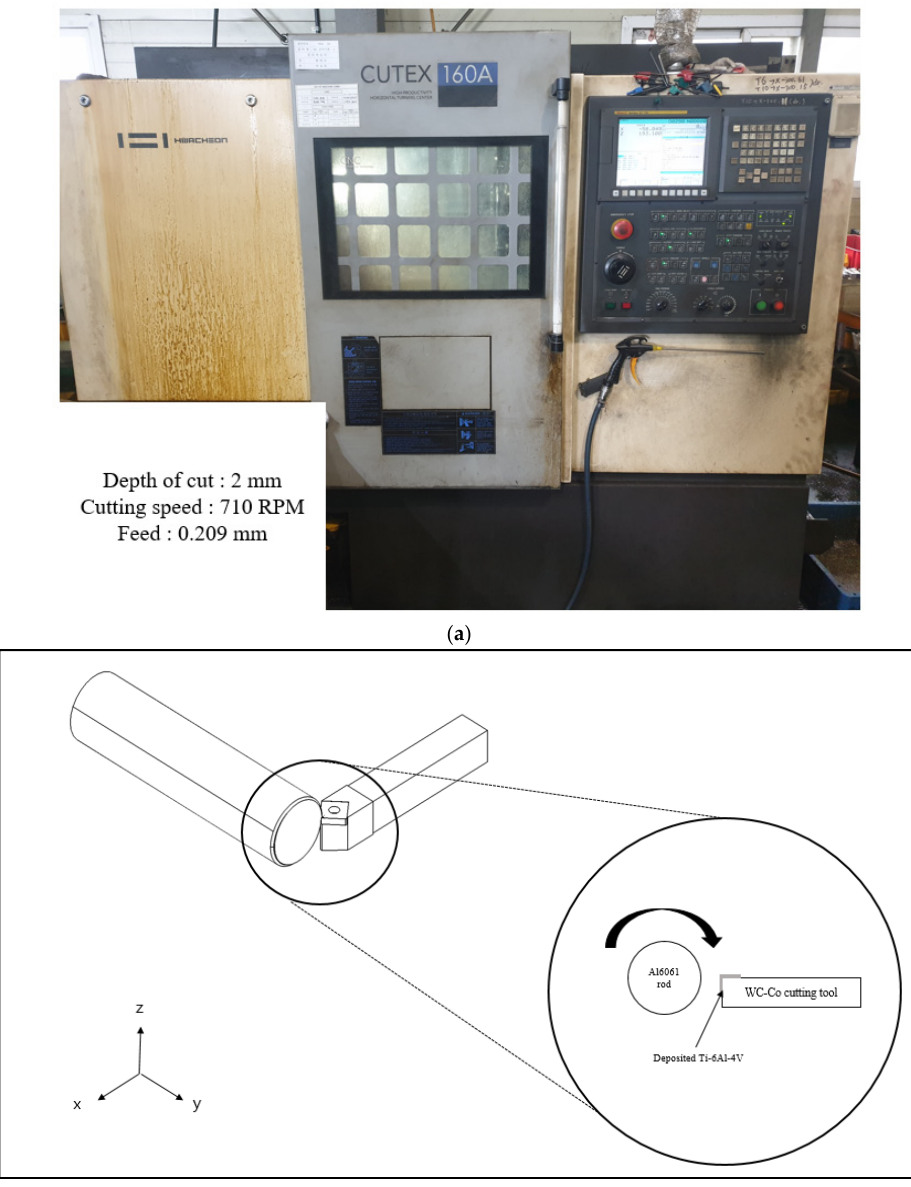
Figure 9. Titanium alloy deposited insert in the turning process: ( a ) CNC machine; ( b ) Schematic diagram of the turning process by the cutting tool insert deposited by AM of titanium alloy powder.